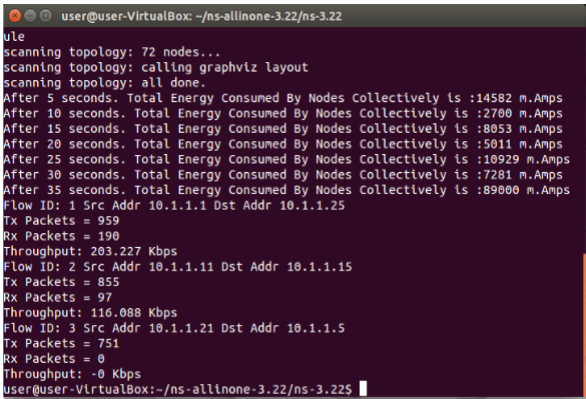
Figure 10. Energy-Utilization w.r.t. LEATCH